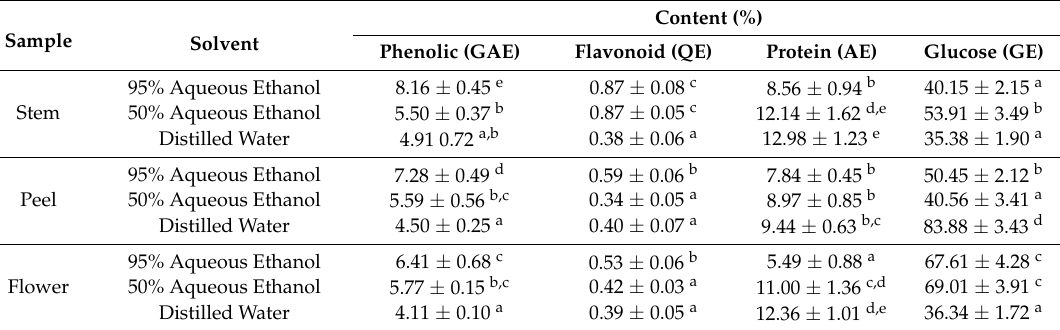
Table 2. The composition of the extracts from Hylocereus polyrhizus